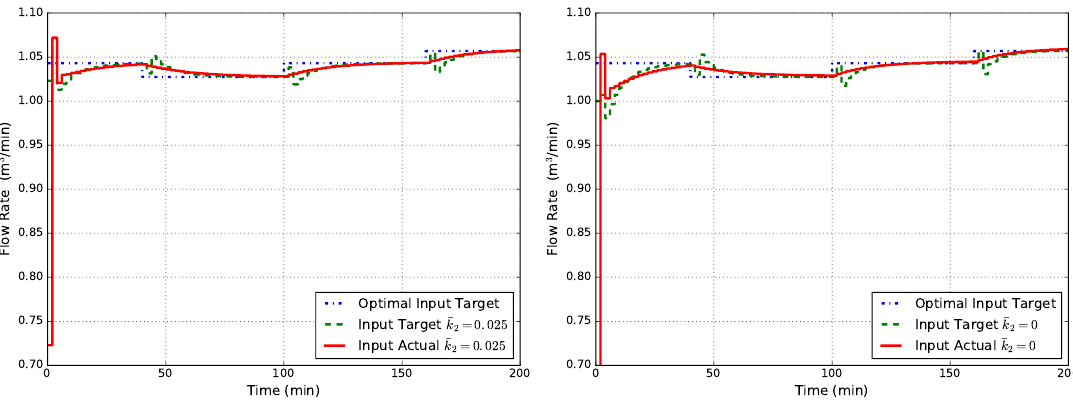
Figure 9. Closed-loop flow rate Q obtained with EMPC1-MT-MD (state disturbance model, modified target problem, modified FHOCP) for cases of unknown time-varying k 2 : the MPC model uses a fixed value of ¯ k 2 = 0.025 ( left ) and ¯ k 2 = 0.025 ( right